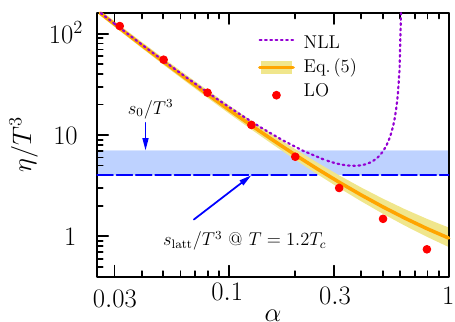
Figure 1. The viscosity, for n f = 0, to LO and NLL accuracy, and from our estimate (5). To illustrate that η cannot explain η / s ∼ < 0.5 (but η may), we also show the constraint for the entropy, 4 T 3 ≤ s ≤ s 0 NLL LO for T > 1.2 T c (see main text). Near the deconfinement temperature T c the entropy of the QGP is notably smaller than s 0